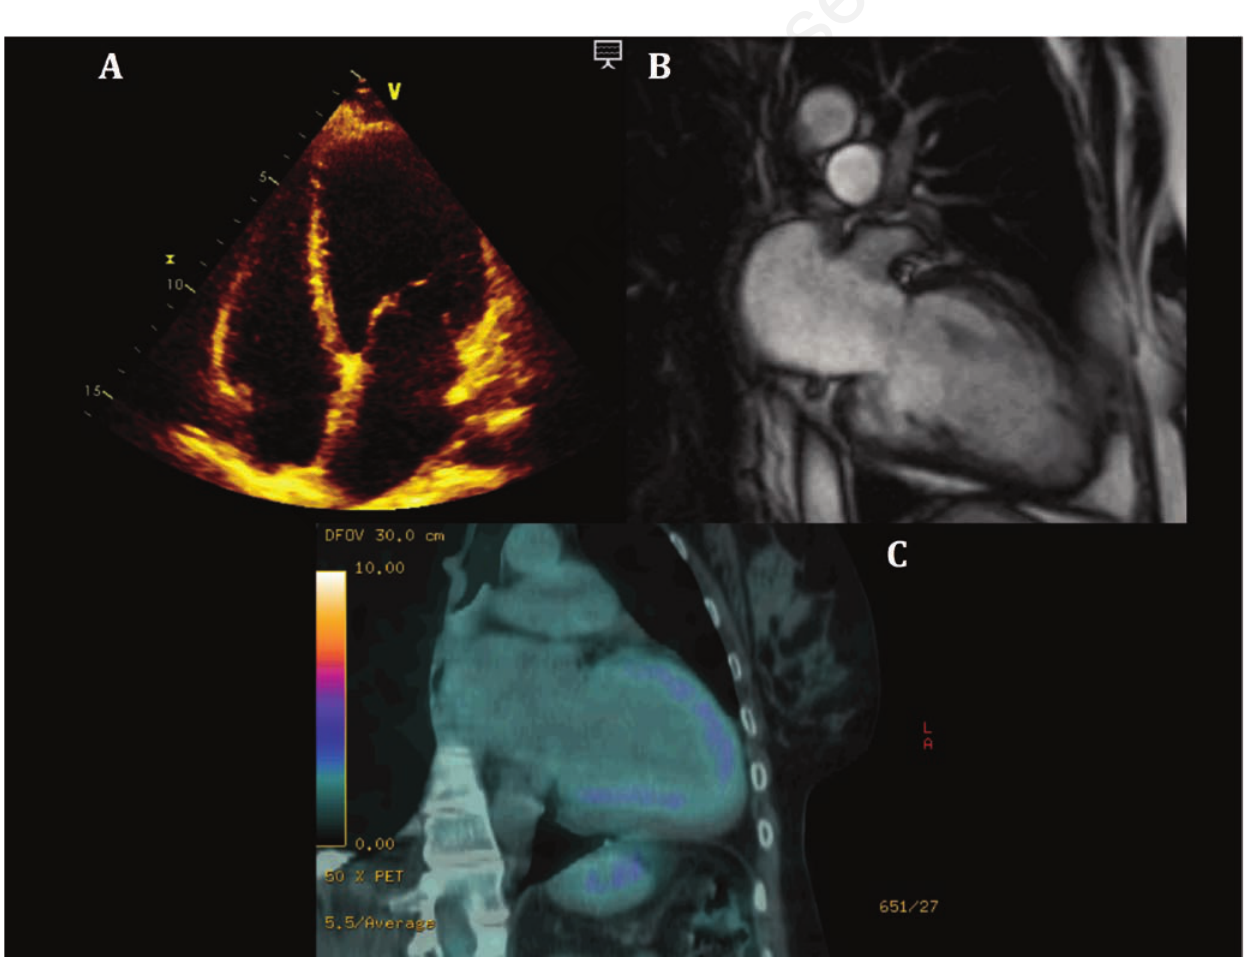
Figure 2. A) Apical 4-chambers view on echocardiography showing left ventricular dilatation; B) Left ventricular dilatation confirmed on cardiac magnetic resonance image; C) Mild and diffuse left ventricular enhancement showed on 18F-FDG-PET